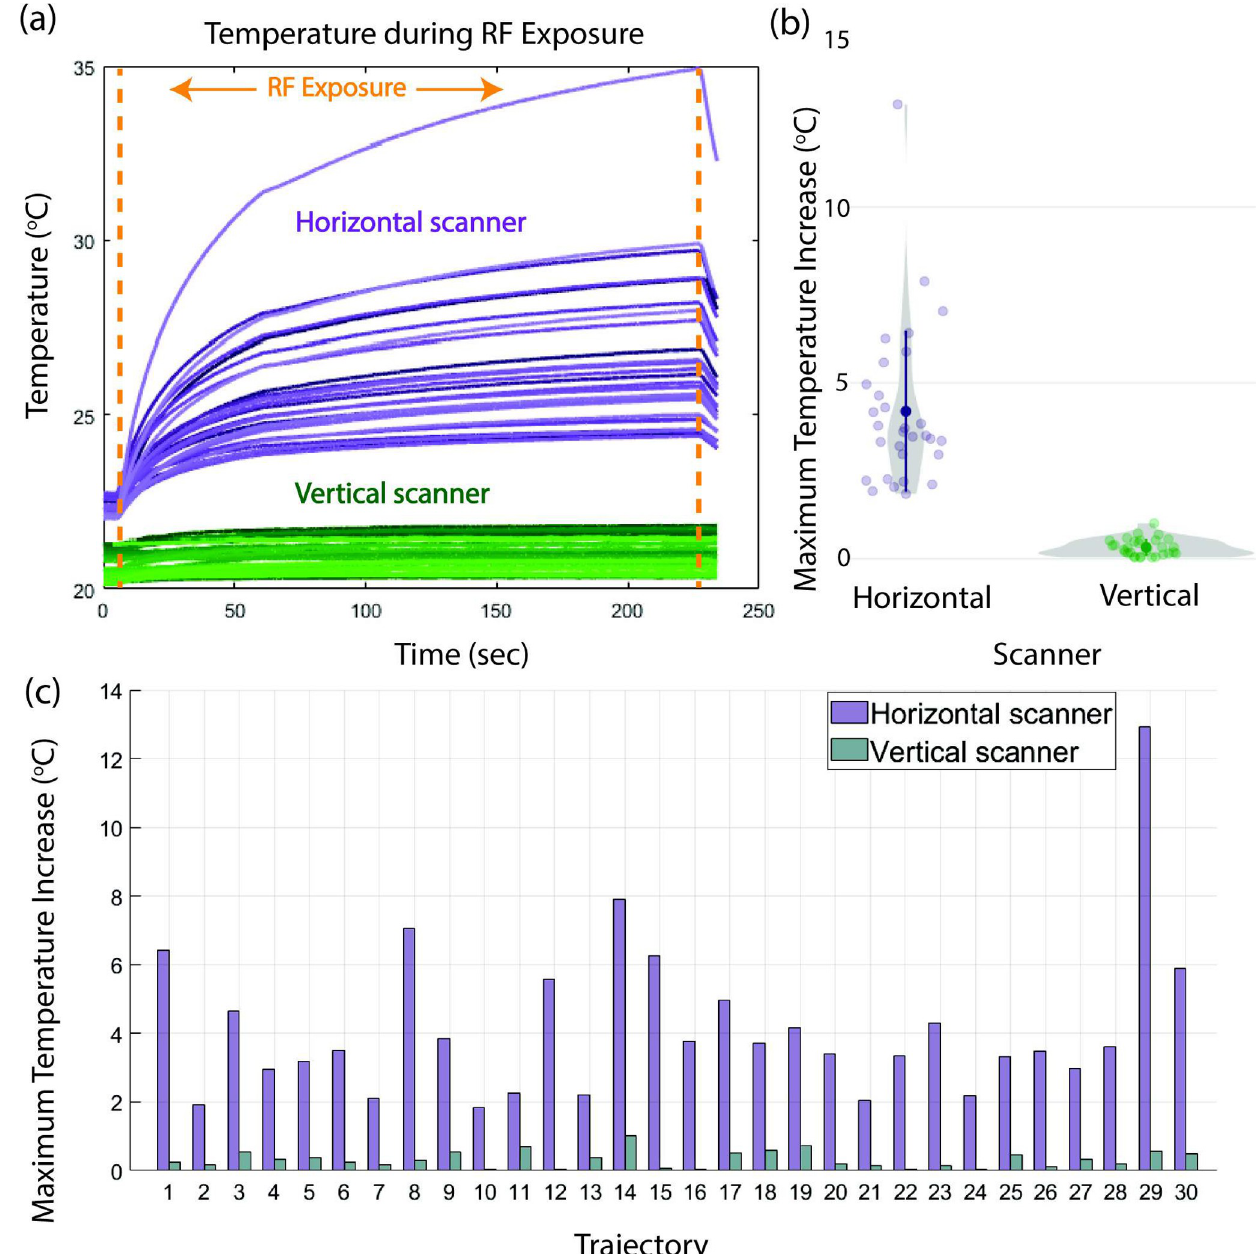
Fig 5. Experimental temperature results. (a) Measured temperature at the DBS lead-tip before, during, and after radiofrequency (RF) exposure in the horizontal and vertical scanners. (b) Violin plots of the maximum temperature increase in the horizontal and vertical scanners. The shaded circles and sprouting lines represent the mean and ± one standard deviation, respectively. (c) The maximum temperature increase during RF heating experiments for each